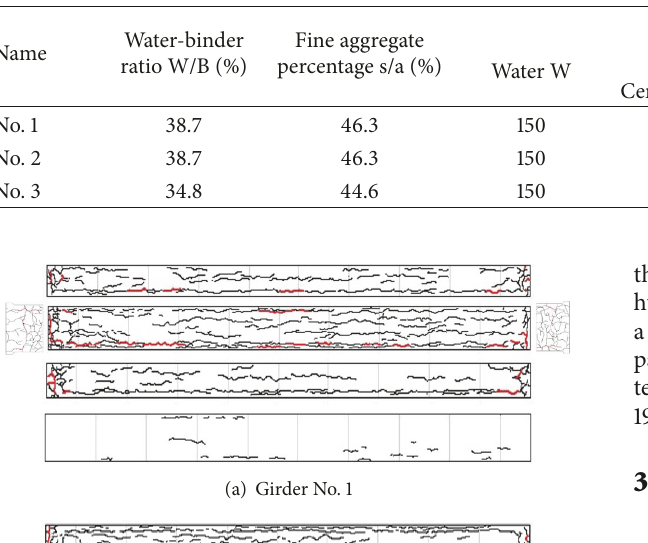
Table 1: Mixture properties.